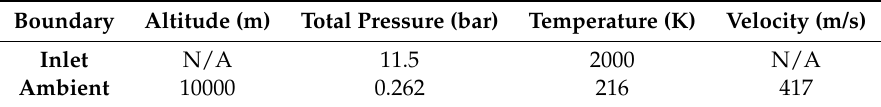
Table 6. Boundary conditions for computational fluid dynamics (CFD) validation.